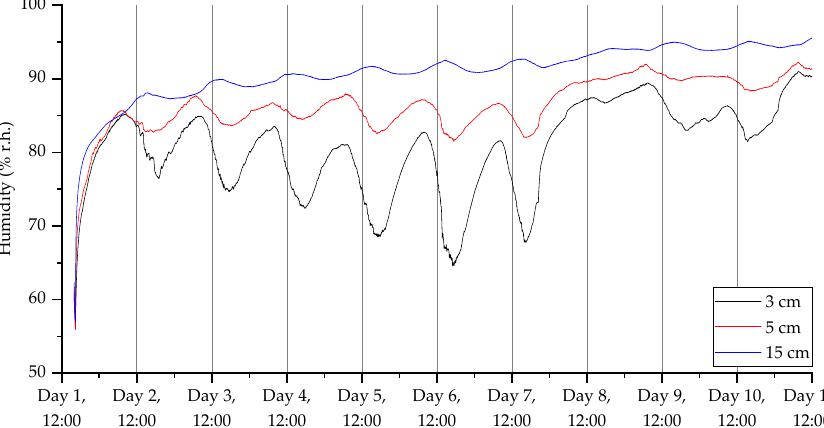
Figure 18. Humidity measurements for the third deployment in Wellesbourne campus woodland. Data collection commenced on 26 August 2022 at 16:00 (24 h time).